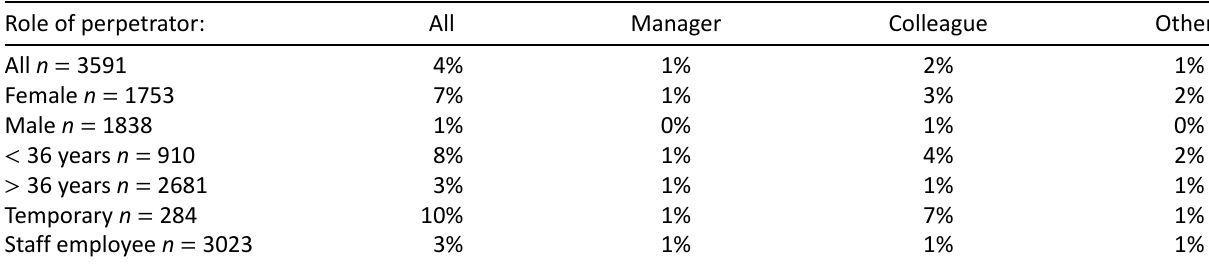
Table 2. Frequency of experienced SH in last six